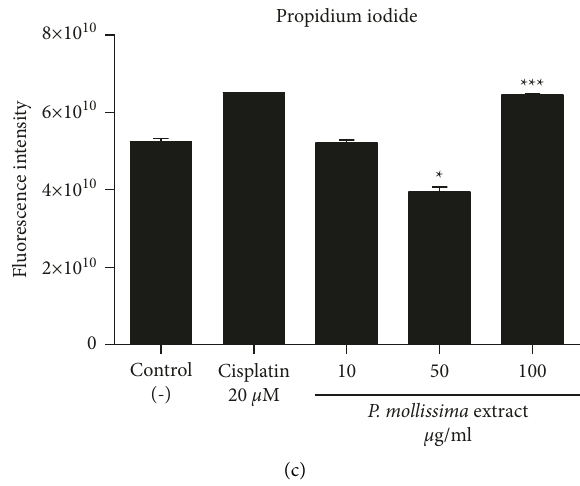
Figure 5: Assessment of 3D spheroid viability changes under PME treatment. Representative images of the proapoptotic effect of PME (10, 50, and 100 μ g/ml) and 20 μ M cisplatin at 72h. Spheroids stained with Hoechst and propidium iodide (PI). (A1) Merged image (red and blue dyes). Spheroids control does not show double marking. White arrows ( ⟶ ) represent apoptotic cells. [2, 3] Fluorescence intensities of Hoechst and propidium iodide in CAL 27 spheroid treated with different concentrations of PME and 20 μ M cisplatin at 72hours using the ImageJ analysis software. Data are shown as median and interquartile range of 3 independent experiments. ∗∗∗ p < 0.05 vs. control.